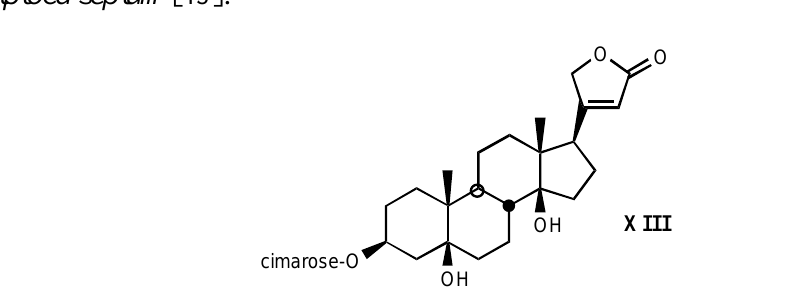
Figure 8. Digitalis-like glycoside displaying cardiotonic activity isolated from Periploca sepium ( XIII ).